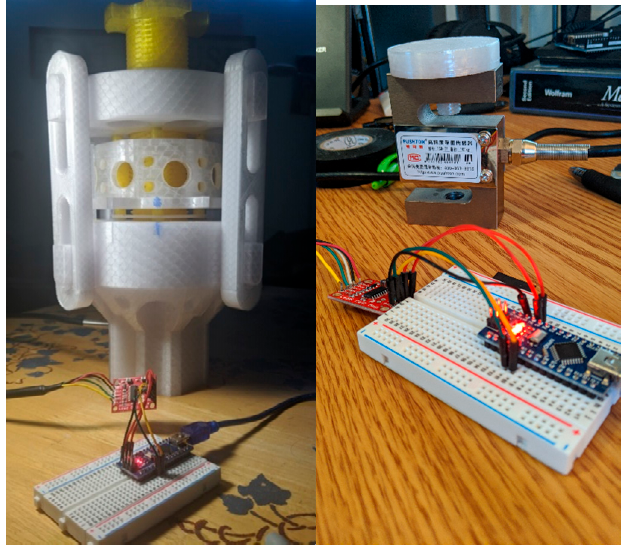
Figure 3. Image of 3D-printed polyethylene terephthalate glycol (PETG) roller screw during testing ( left ) and load cell with a push plate that was inserted into the test stand assembly ( right ).